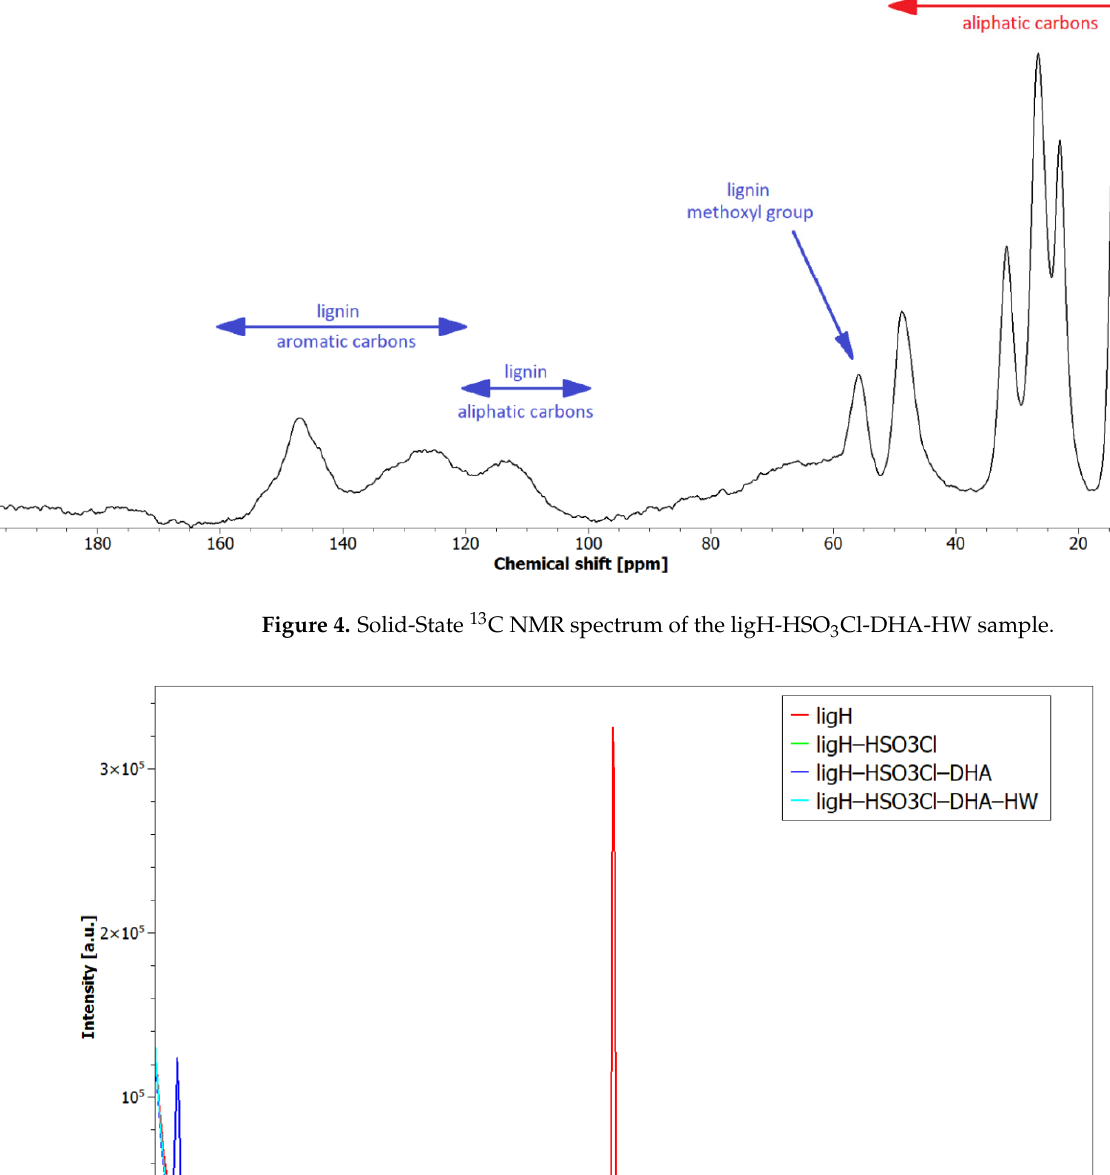
Figure 5. Diffraction patterns of the investigated materials.